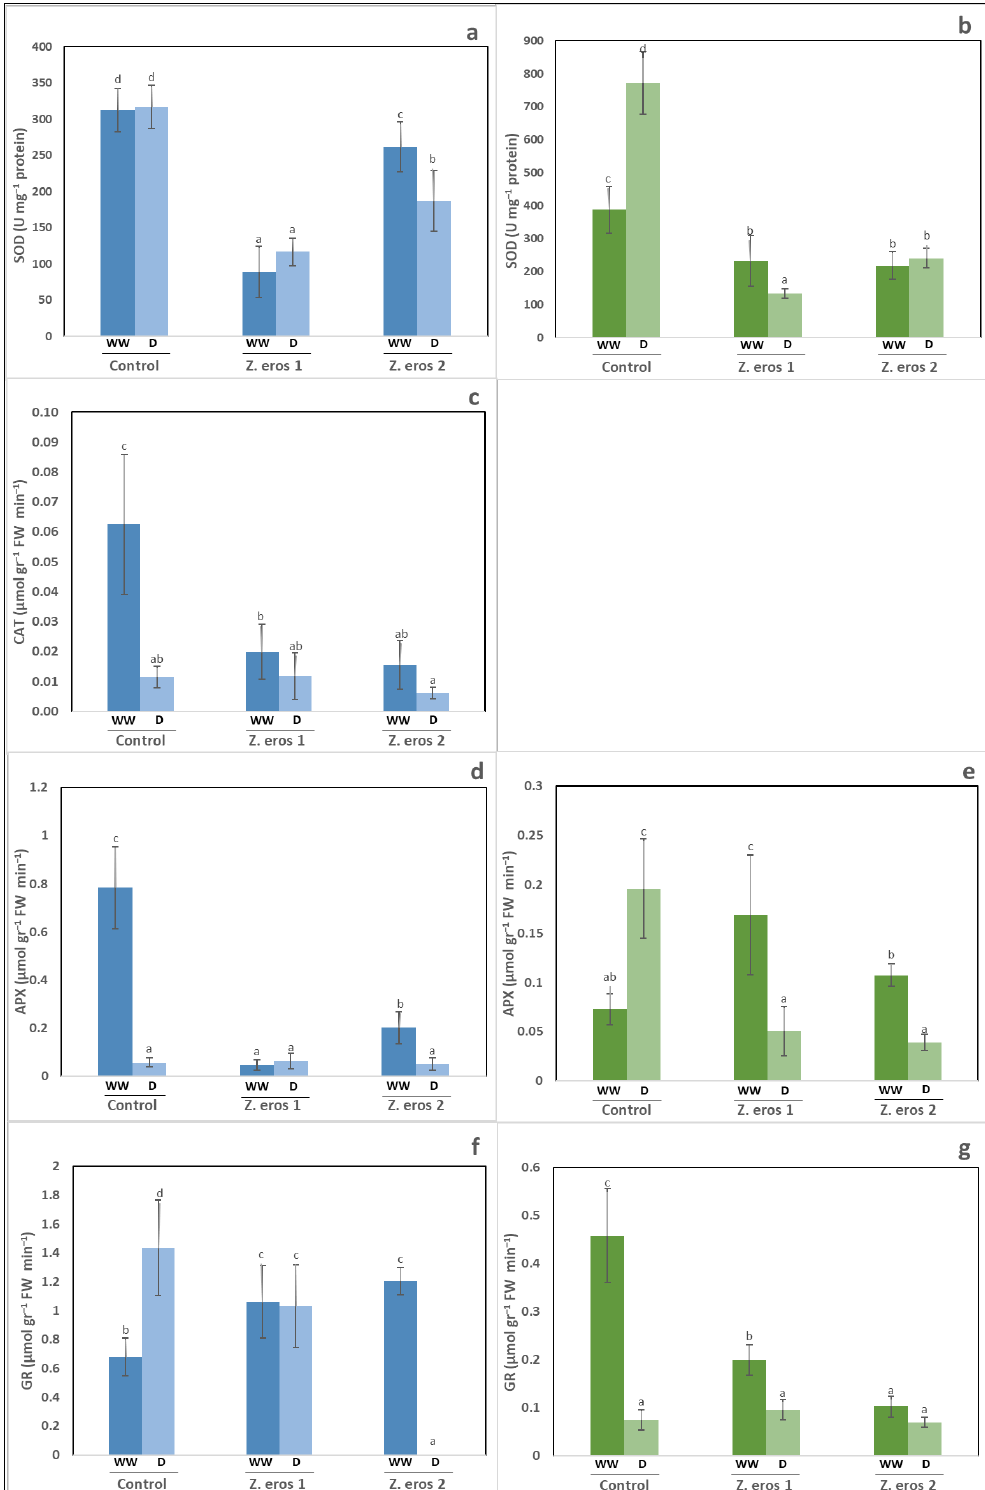
Figure 4. Activities of antioxidant enzymes (SOD, CAT, APX, GR) assayed in shoots of wheat ( a , c , d , f ) and tomato ( b , e , g ). Plants were inoculated with the fungal endophytes Z. erostrata 1 y Z. erostrata 2 under well-watered (WW) or to drought (D) conditions. Values represent the means ± standard deviation of four replicates. Significant differences are indicated by different letters above the bars according to Duncan’s multiple-range test ( p < 0.05).